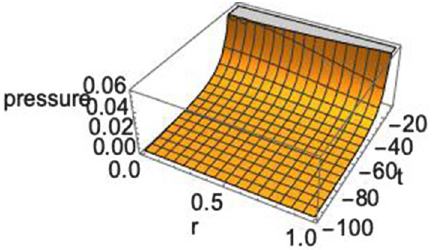
Fig. 2 Pressure as a function of the radial and temporal coordinates